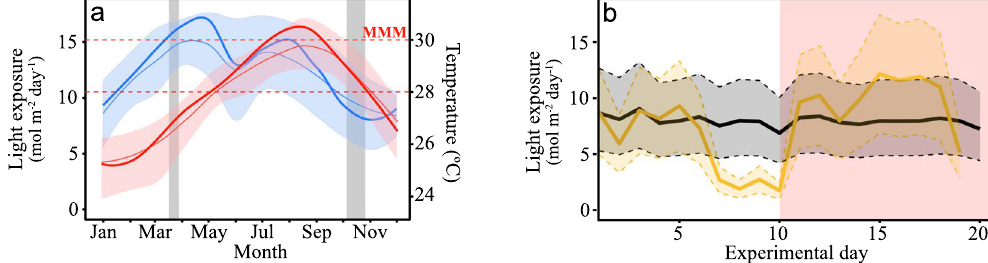
Figure 1. Description of the natural and experimental variation in light and temperature. ( a ) Monthly average values (thin lines) ± STD (shaded areas) for the annual variation of diurnal light exposure (mol quanta m − 2 day − 1 ) for the period 2011 to 2014 (in blue), and seawater temperature (°C) for the period 1992 to 2015 (in red). Thick solid lines describe average values during 2011for light exposure (blue line) and temperature (red line). Dashed horizontal red lines indicate annual average seawater temperature (28 °C), and local value for MMM (29.8 ≈ 30 °C), for the reef lagoon of Puerto Morelos. ( b ) Diurnal variation in light exposure (mol quanta m − 2 day − 1 ) during the experiments, values for March 2011 in grey, and for October 2011 in orange. The solid line represents diurnal light exposure for the medium-control light treatment (ML), whereas the upper and lower dashed lines describe, respectively, high light (HL) and low light (LL) treatment values. The red area from day 10 to day 20 shows the variation in diurnal light exposure during the extended 10 days of heat-stress applied in October 2011. In March, corals were back to control conditions (28 °C) after the application of the heat-stress treatments for 10